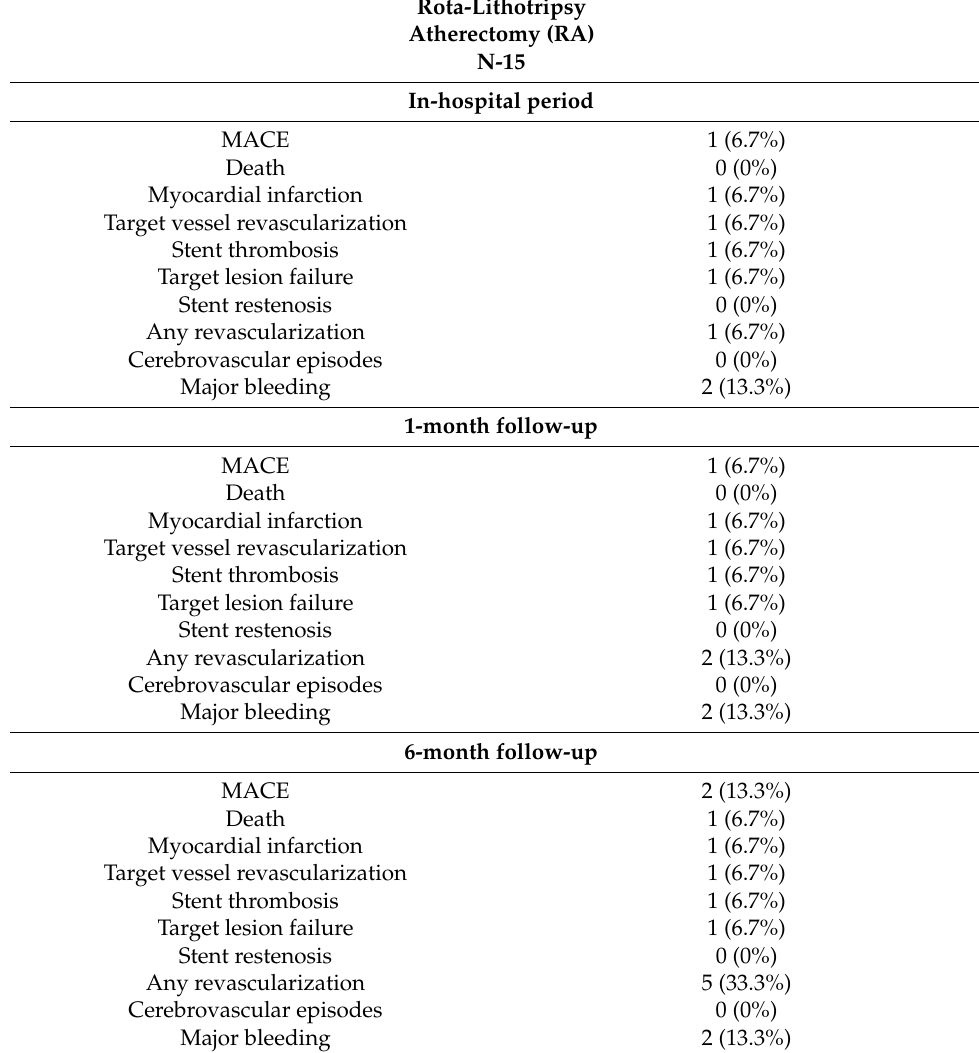
Table 3. Clinical outcomes of the study